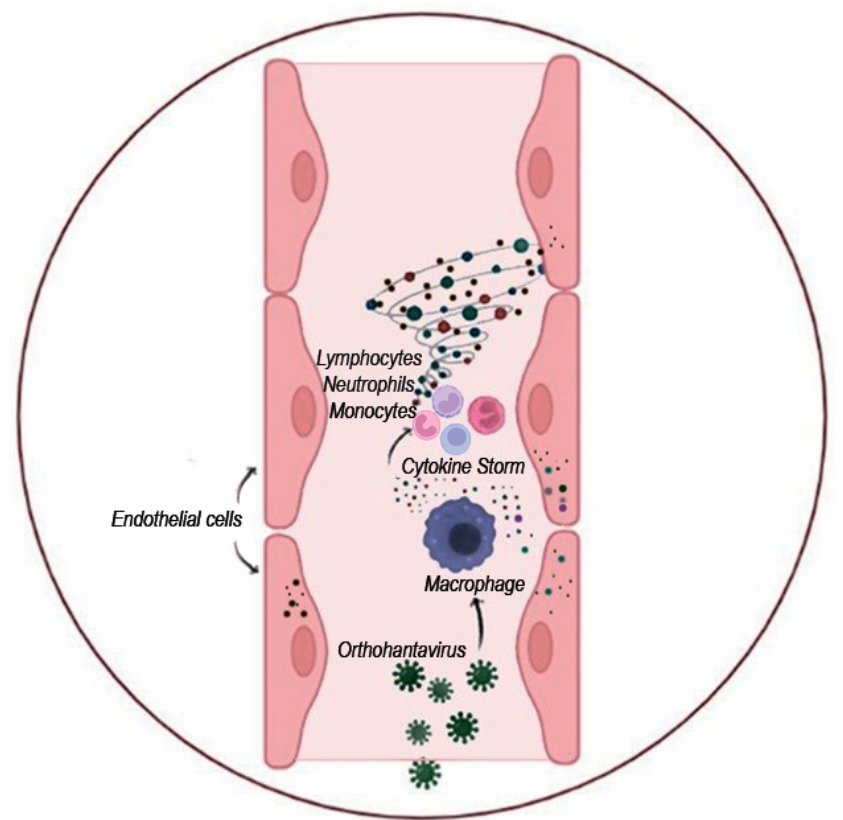
Figure 5. Schematics of “cytokine storm” activation upon orthohantavirus infection. Orthohantavirus infection activates endothelial cells and leukocytes to produce various cytokines. These cytokines could activate leukocytes and attract them to the site of infection. Massive infiltration of leukocytes producing proinflammatory cytokines and chemoattractants could induce severe local inflammation inflicting tissue destruction.